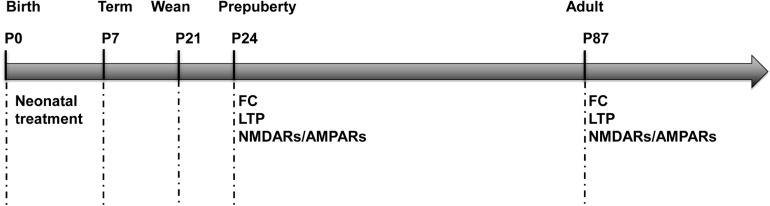
Experimental protocol. FC, fear conditioning; LTP, long-term potentiation; NMDARs, N-methyl-D-aspartic acid receptors; AMPARs, α-amino-3-hydroxy-5-methyl-4-isoxazolepropionic receptors.